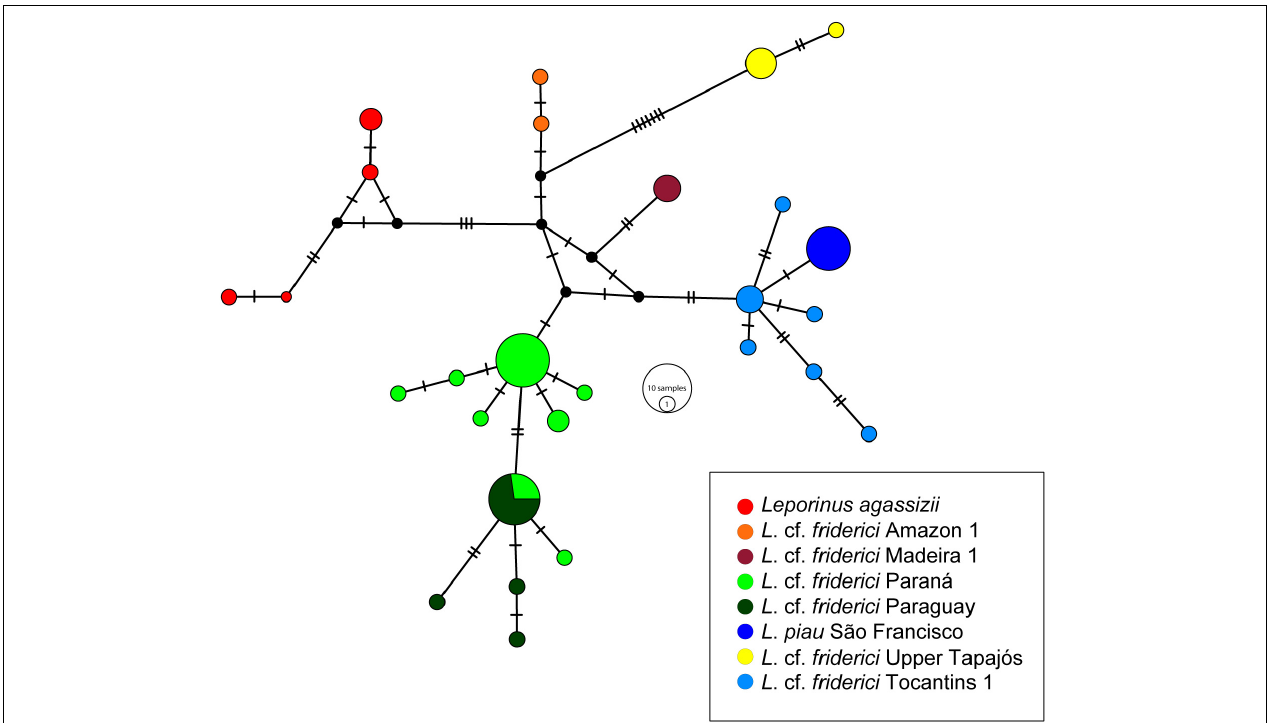
FIGURE 4 | The Median Joining haplotype network of Leporinus cf. friderici sensu stricto clade using COI gene data. The small dark dots indicate the missing or not sampled haplotypes. The haplotypes are shown in different colors according to each MOTU in